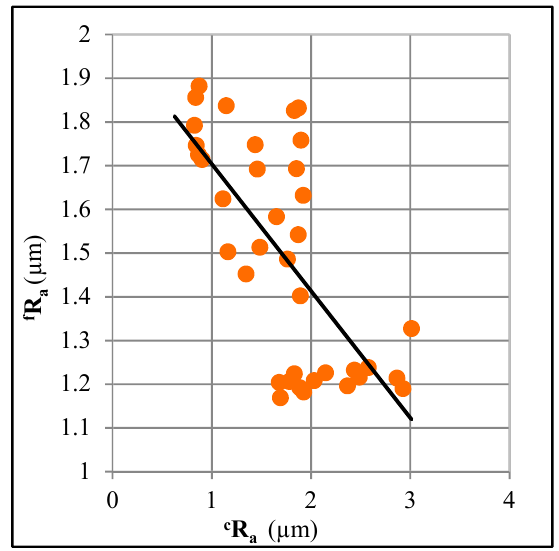
Figure 10. Correlation between the free-surface roughness and contact-surface roughness.